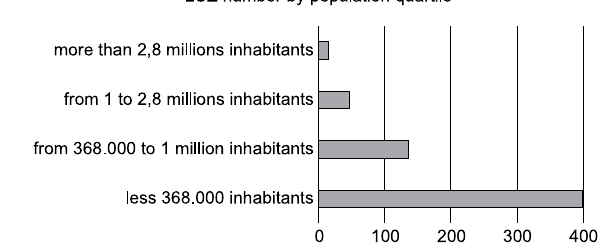
Fig. 5. LUZ number by population